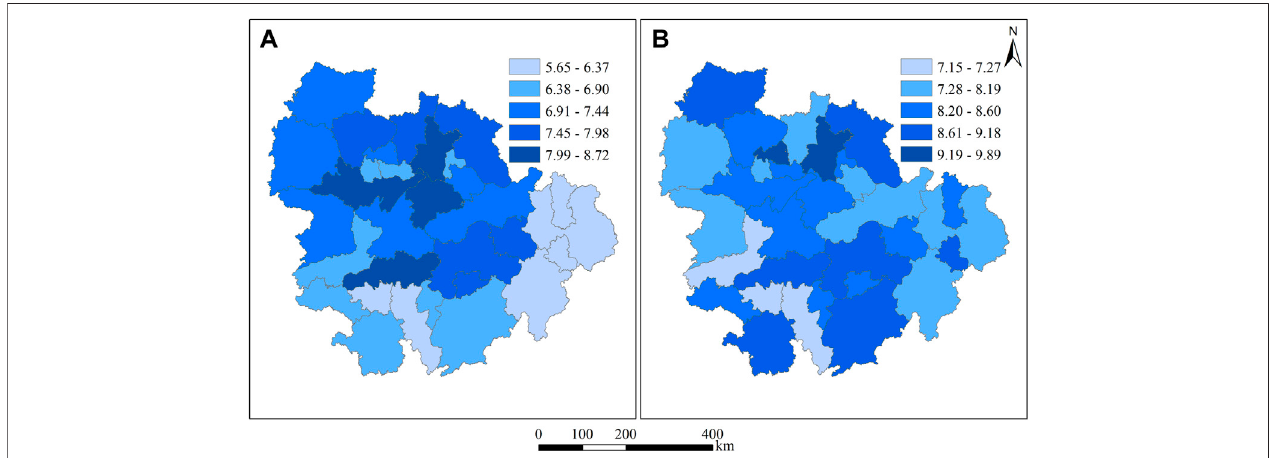
FIGURE6| LNformatoftheinteractionbetweentheexpandedconstructionlandandtheexpandedcroplandintheperiodsof (A) 2000 – 2010and (B) 2010 – 2020.